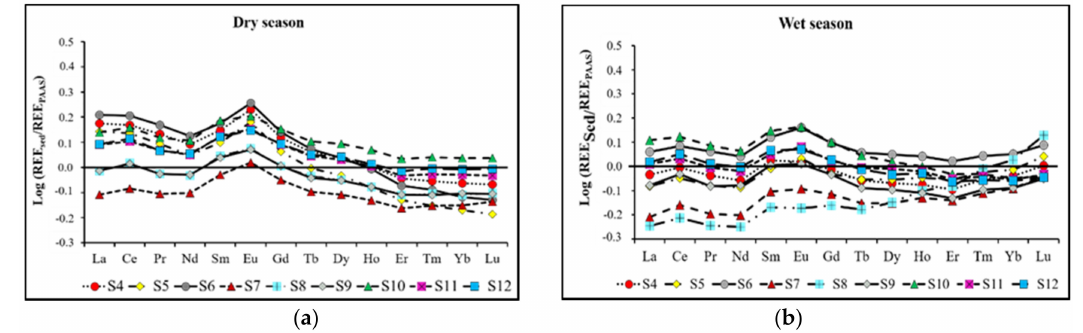
Figure 4. Distribution patterns of REE concentrations normalized to the PAAS concentrations in the fine sediments ( < 63 µ m) of the di ff erent Lom é lagoon sites (S4 to S12) during the dry ( a ) and the wet ( b ) seasons. See the concentrations for each site in Table S2 (Supplementary